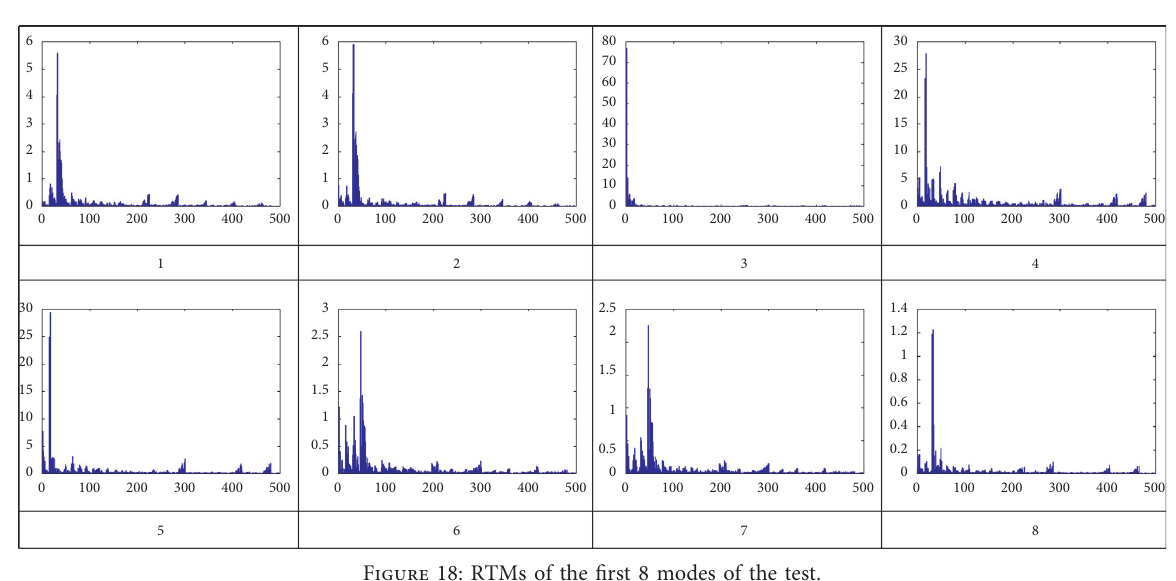
Figure 18: RTMs of the first 8 modes of the test.